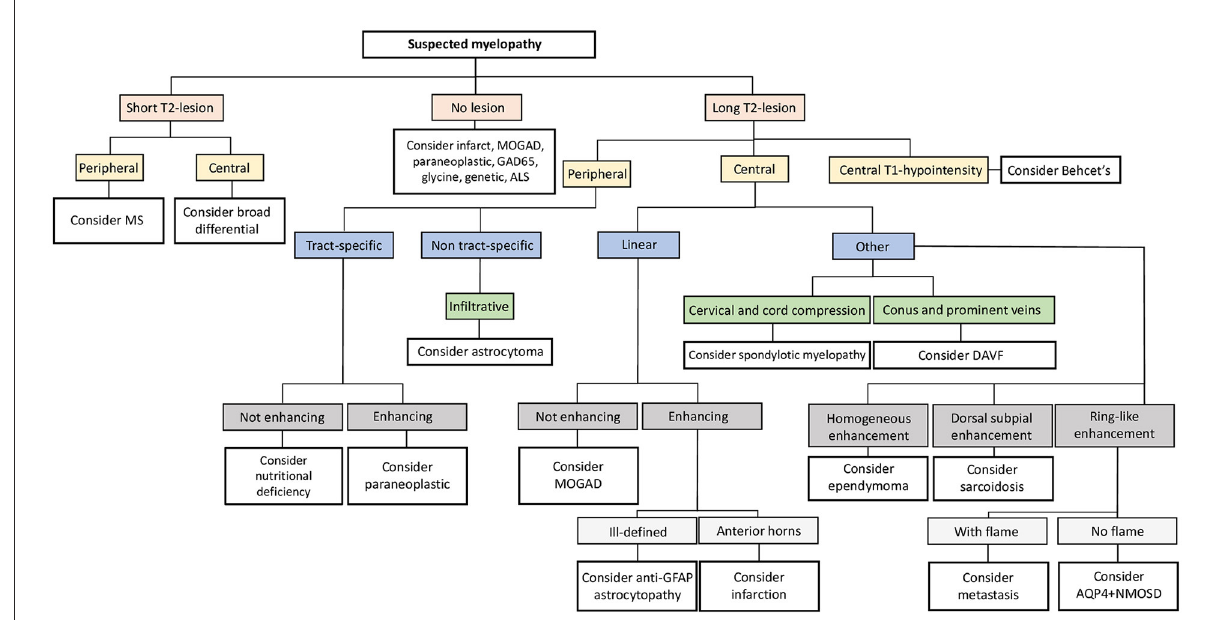
FIGURE5 Neuroimaging approach to the differential diagnosis of suspected myelopathies. Flow-chart summarizing a possible diagnostic approach to suspected myelopathies from an imaging perspective. ALS, amyotrophic lateral sclerosis; AQP4 + NMOSD, aquaporin-4-IgG-positive neuromyelitis optica spectrum disorders; DAVF, dural arteriovenous fistula; GAD65, glutamic acid decarboxylase-65; GFAP, glial-fibrillary acidic protein; MOGAD, myelin oligodendrocyte glycoprotein antibody-associated disease; MS, multiple